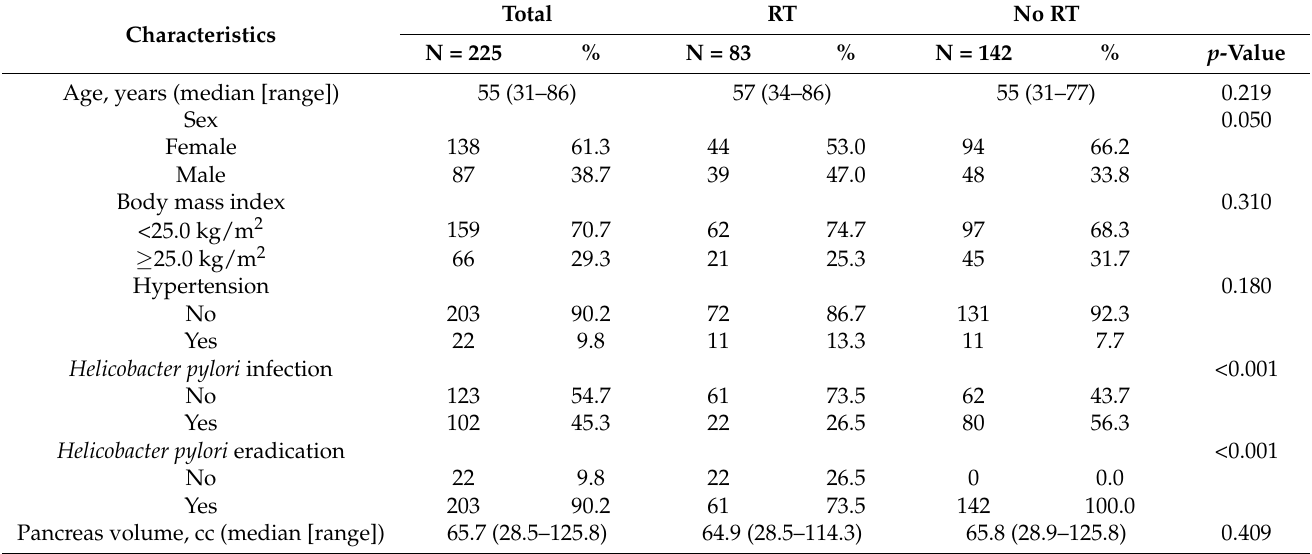
Table 1. Baseline characteristics of all the patients and patients treated with or without radiotherapy.